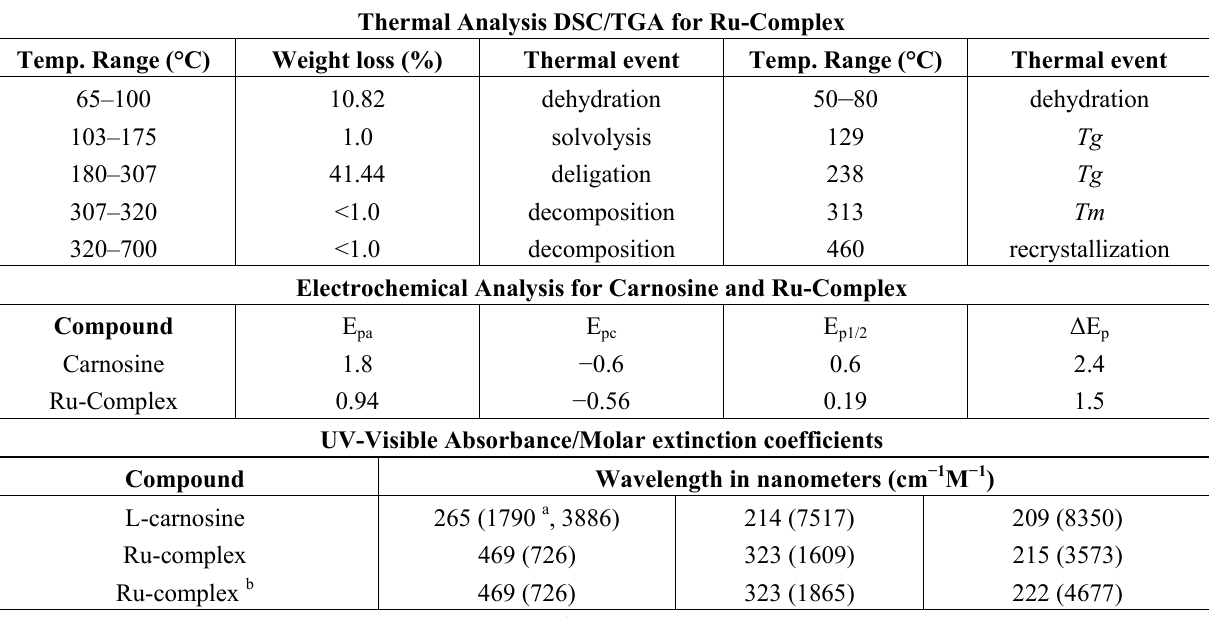
Table 2. Thermal, electrochemical, and electronic spectroscopy data